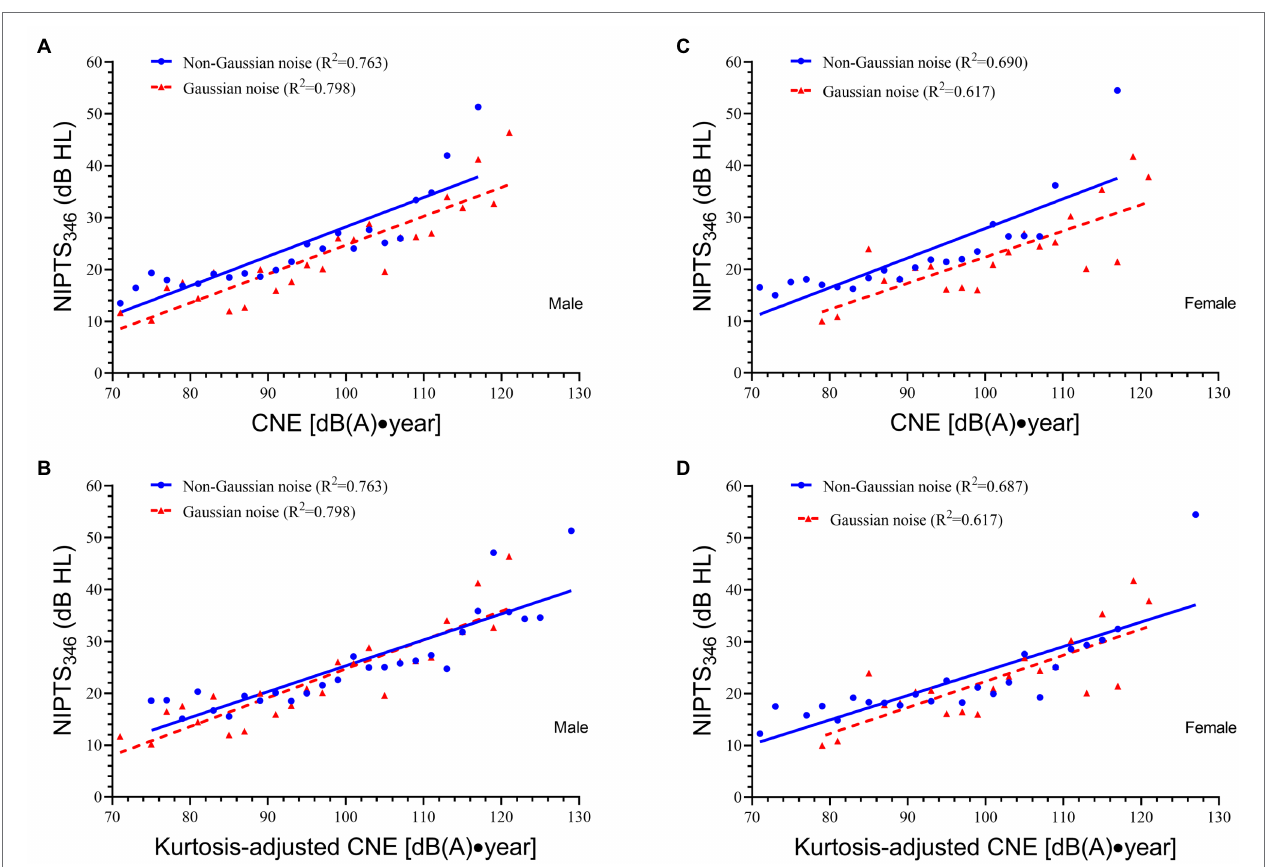
FIGURE 2 | The linear relationship between NIPTS 346 and CNE or CNE ′ for male and female workers. (A) The linear relationship between NIPTS 346 and CNE for male workers. The regression equation for Gaussian noise is NIPTS 346 = 0.556CNE—30.910, R 2 = 0.798. The regression equation for non-Gaussian noise is NIPTS 346 = 0.568CNE ′ —28.599, R 2 = 0.763. (B) The linear relationship between NIPTS 346 and CNE ′ for male workers. The regression equation for non-Gaussian noise is NIPTS 346 = 0.499CNE ′ —24.598, R 2 = 0.763. (C) The linear relationship between NIPTS 346 and CNE for female workers. The regression equation for Gaussian noise is NIPTS 346 = 0.504CNE—28.037, R 2 = 0.617. The regression equation for non-Gaussian noise is NIPTS 346 = 0.571CNE ′ —29.231, R 2 =